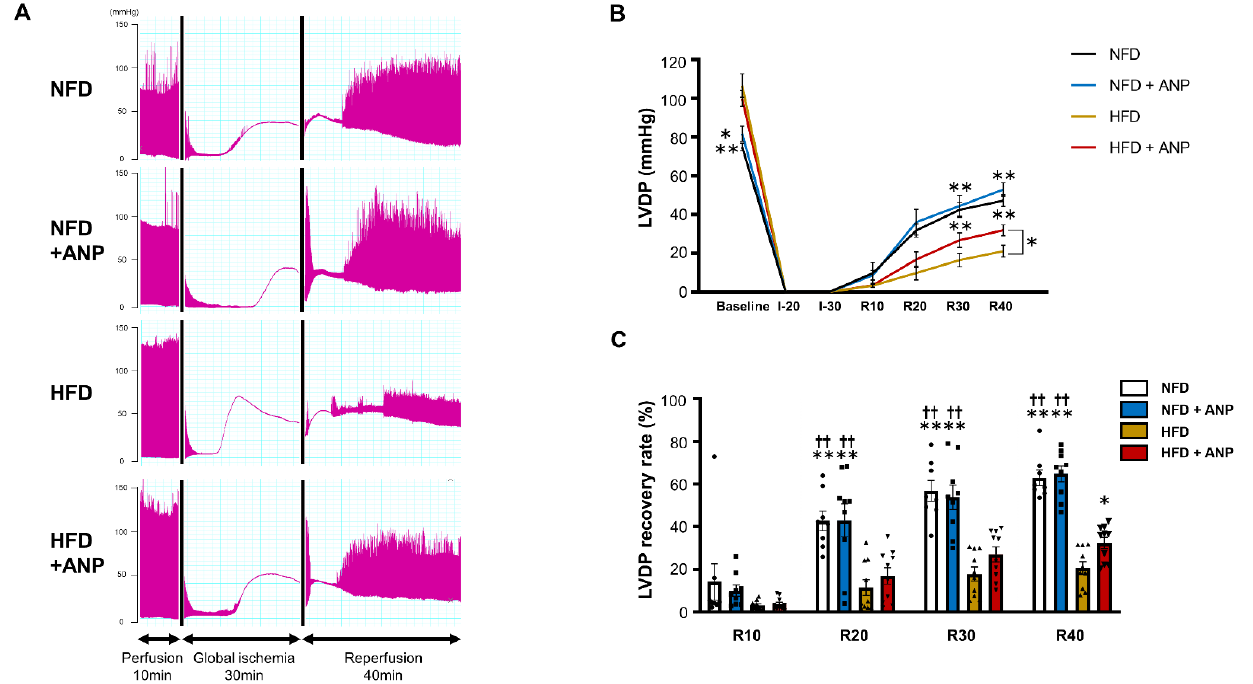
Figure 3. Cardiac functional recovery after IRI with or without ANP treatment. ( A ) Representative tracing of LVDP during ischemia–reperfusion with or without ANP treatment. LVDP profiles ( B ) and LVDP recovery (percent of baseline) ( C ) measured at the indicated time points during ischemia– reperfusion in NFD (n = 8), NFD+ANP (n = 9), HFD (n = 10), and HFD+ANP (n = 10) hearts are shown. * p < 0.05 and ** p < 0.01 versus HFD, †† p < 0.01 versus HFD+ANP. I, ischemia; LVDP, left ventricular-developed pressure; R, reperfusion. Table 1. Baseline cardiac function of ex vivo perfused hearts with or without ANP treatment. ‡ p < 0.05 and ‡‡ p < 0.01 versus the NFD group. HFD, high-fat diet; HR, heart rate; LVDP, left ventricular-developed pressure; LVEDP, left ventricular end-diastolic pressure; LVSP, left ventricular systolic pressure; NFD, normal-fat diet; RPP, rate pressure product. NFD NFD+ANP HFD